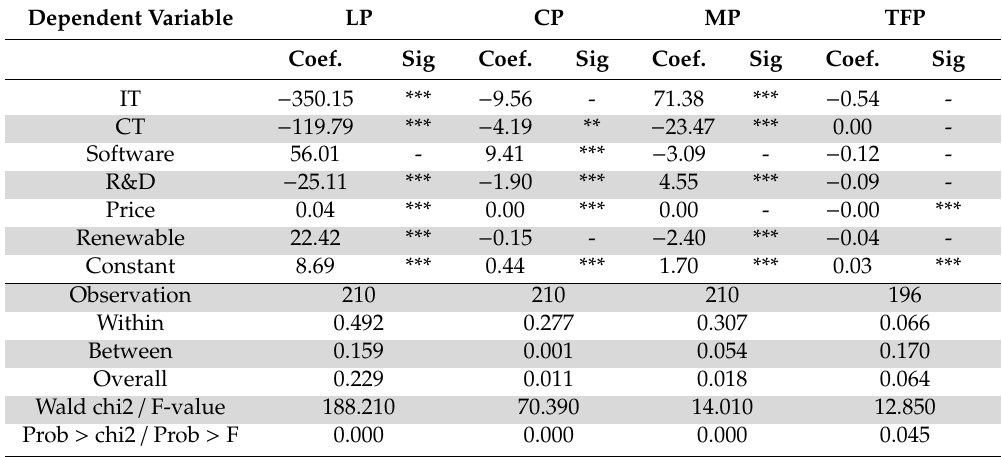
Table 4. The results of the determinant analysis using individual ICT capital data. Dependent